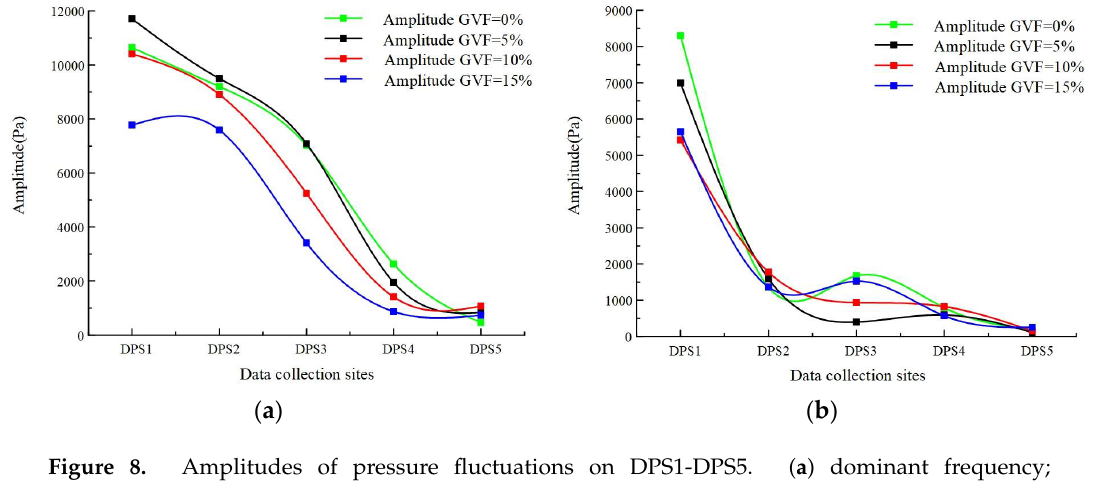
Figure 8. Amplitudes of pressure fluctuations on DPS1-DPS5. ( a ) dominant frequency; ( b ) secondary frequency.